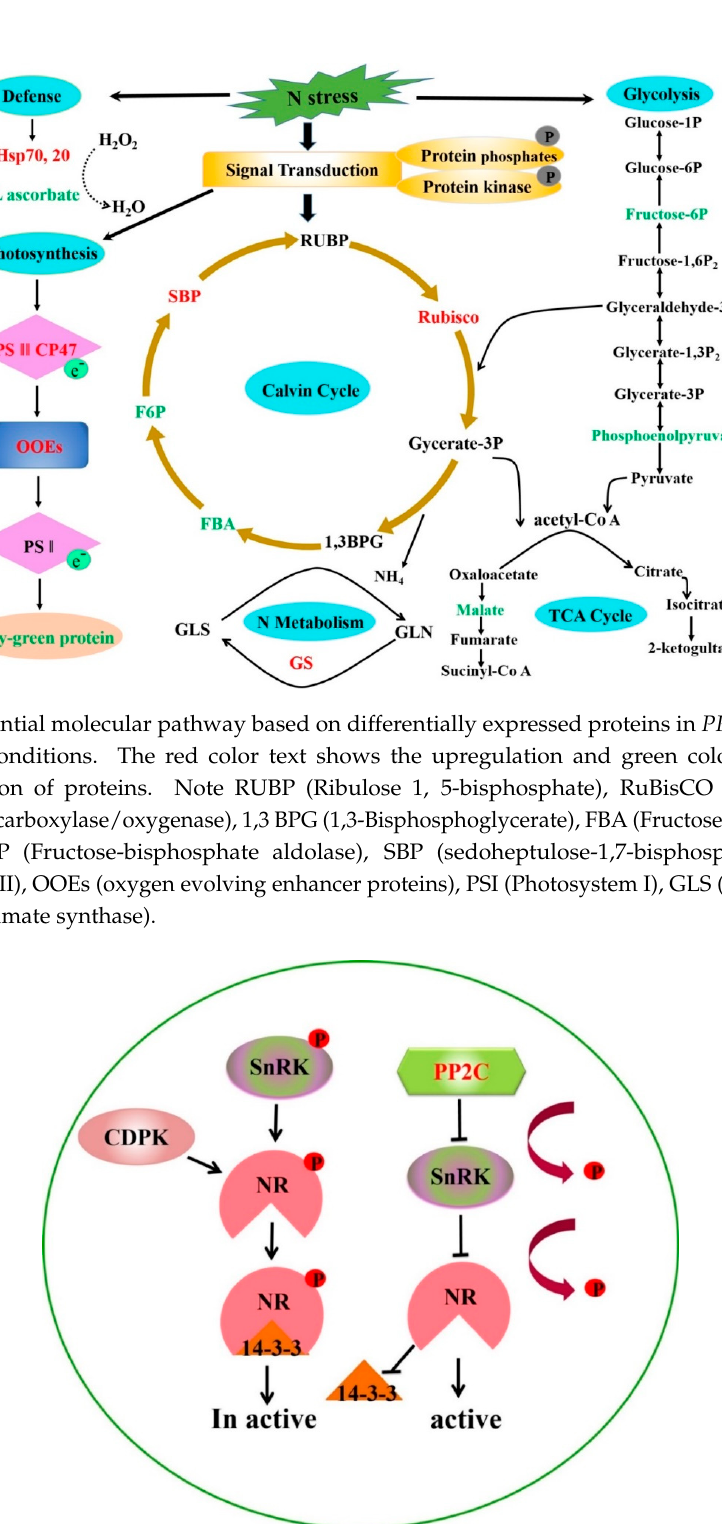
Figure 8. PP2C9 role for nitrate reductase activation by dephosphorylation of SnRK. 14-3-3 proteins SnRK (SNF1-related kinase) and CDPK (calcium-dependent protein kinases) can phosphorylate NR in crop plants. After phosphorylation of NR, it binds with the 14-3-3 protein to form a complex which is inactive or has low activity. PP2C9 interacts with 14-3-3 and SnRK and dephosphorylates them to activate NR.